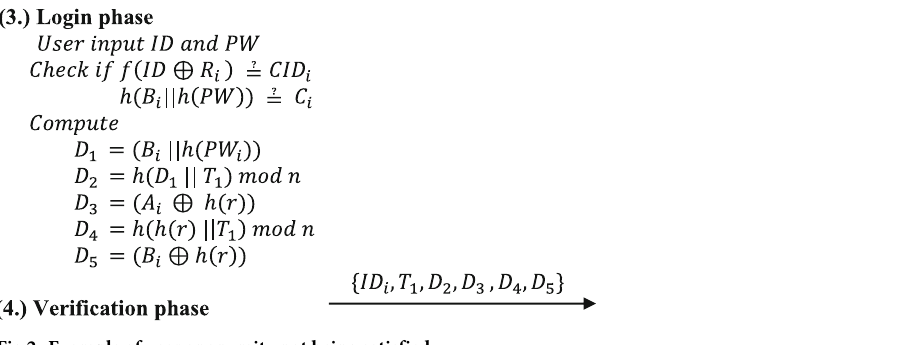
Fig 2. Example of user anonymity not being